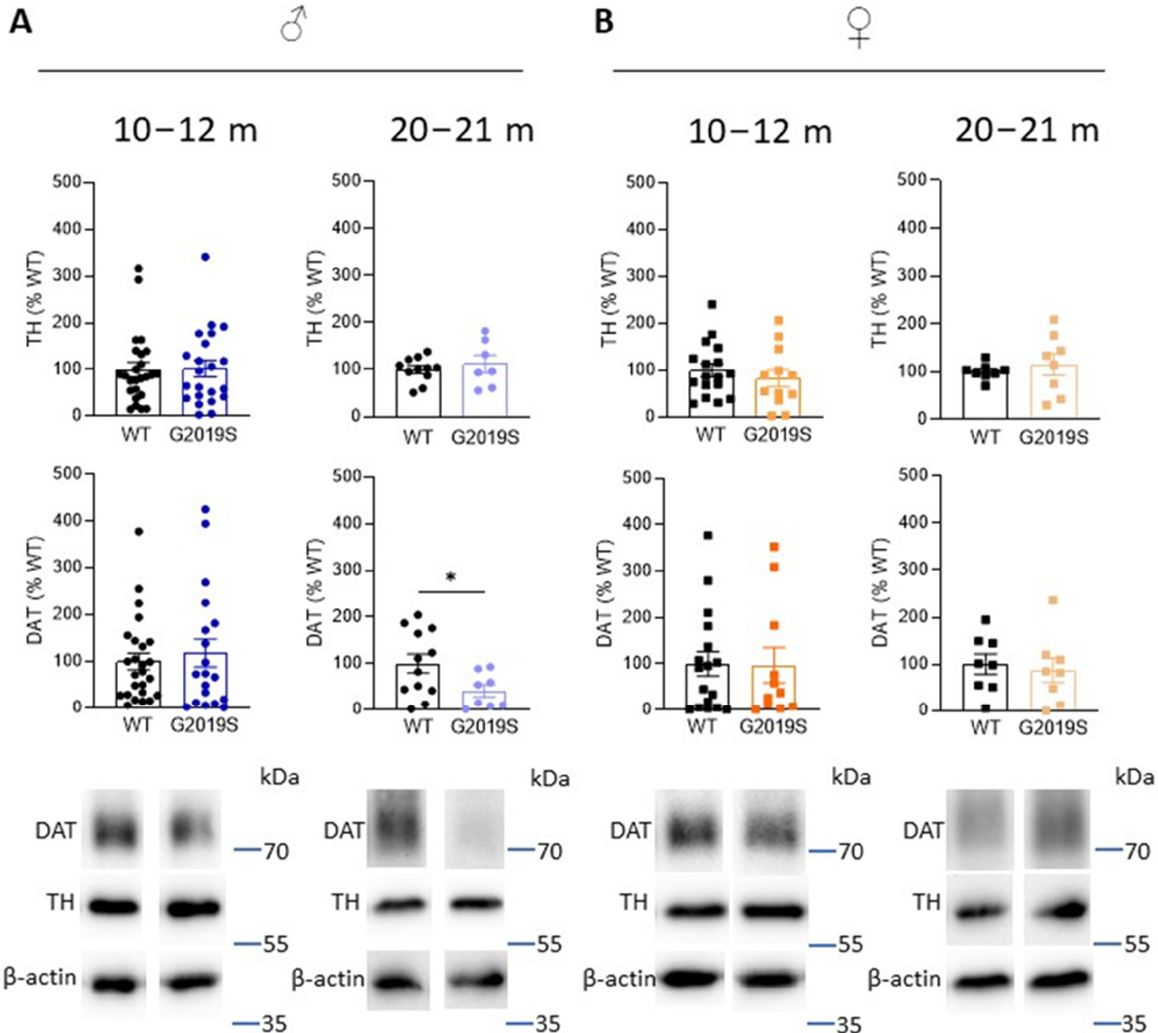
Figure 3. Old male G2019S mice display decreased DAT amount in the striatum. West- ern blotting of TH and DAT in the striatum of 10–12 months old and 20–21 months old male ( A ) and female ( B ) WT and G2019S mice. N = 4–25 mice in each group. * p < 0.05 unpaired Student’s t